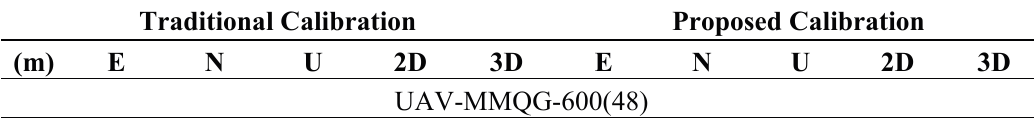
Table 2. The statistical analysis of DG based on traditional calibration method.